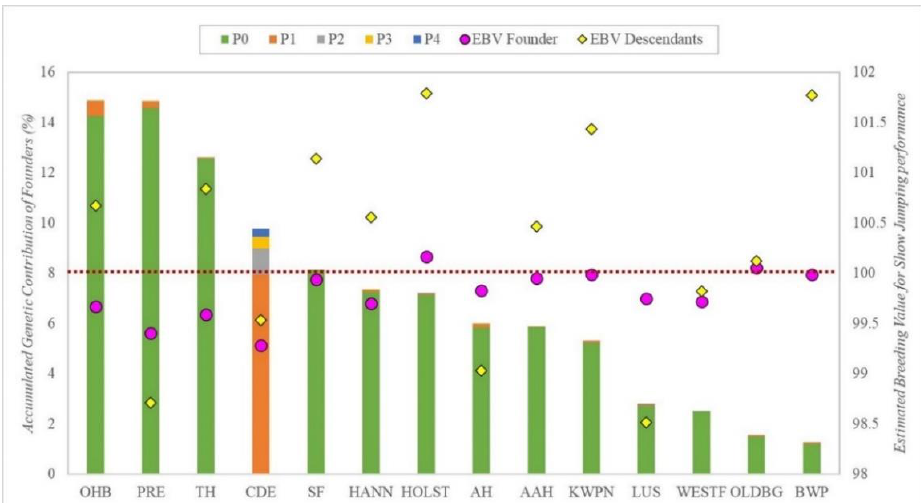
Figure 3. Genetic contribution of all founders classified by breed (each column), per period (different colors within columns), with their mean estimated breeding value (EBV Founder; pink circles) and the mean estimated breeding value of their descendants (EBV Descendants.; yellow rhombuses) for Show Jumping discipline, ordered according to contribution level of the founders. Where AAH is Anglo-Arab Horse, AH is Arab Horse, BWP is Belgian Warmblood, CDE is Caballo de Deporte Español, HANN is Hannoverian Horse, HOLST is Holsteiner Horse, KWPN is KWPN Horse, LUS is Lusitano Purebred, OLDBG is Oldenburg Horse, OHB is Other Horse Breeds, PRE is Pura Raza Española, TH is Thoroughbred, SF is Selle Français, WESTF is Westfalian Horse, P0 is period with animals born before 2000, P1 between 2000 and 2004, P2 between 2005 and 2009, P3 between 2010 and 2014, P4 after 2015. The red dots line indicate the mean estimated breeding value (EBV=100).